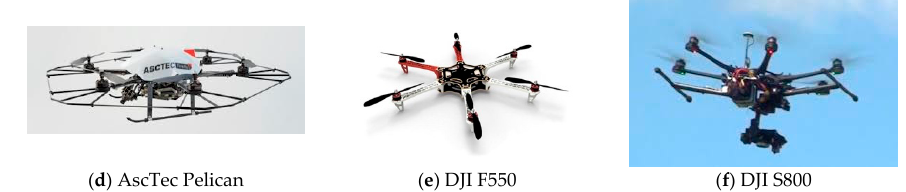
Figure 1. Example of a small fixed wing ( a ) CyberEye II [63]; ( b ) Silvertone Flamingo [64]; ( c ) SenseFly Swinglet [65] and rotary wing ( d ) AscTec Pelican [66]; ( e ) DJI F550 [67]; ( f ) DJI S800 [68] unmanned aircraft (All the UAVs shown are part of the fleet of the Australian Research Centre for Aerospace Automation).